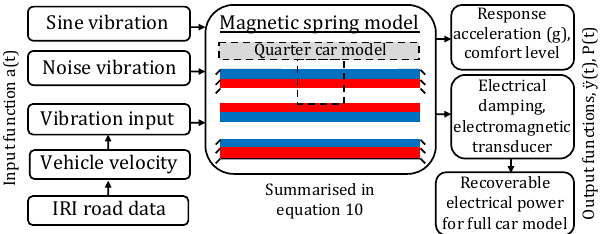
Figure 4. Overview of numerical model used to simulate the behaviour of the quarter vehicle magnetic suspension.